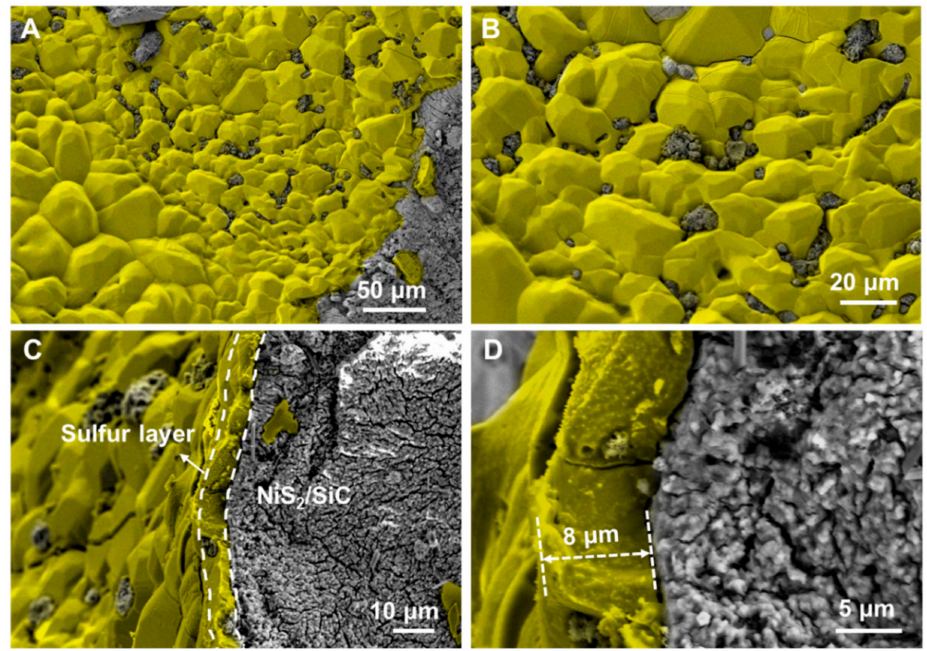
Figure 5. ( A , B ) SEM micrographs of the NiS 2 /SiC foam surface after desulfurization test at 60 ◦ C with 0.5 vol.% of H 2 S and 100 h catalyst on stream; pictures show the presence of large sulfur aggregates on the catalyst surface whereas a large part of the catalyst remains free of sulfur deposit. ( C , D ) Cross-section SEM micrographs showing the presence of a thick layer of sulfur on the catalyst surface. The solid sulfur is colored in yellow in all SEM